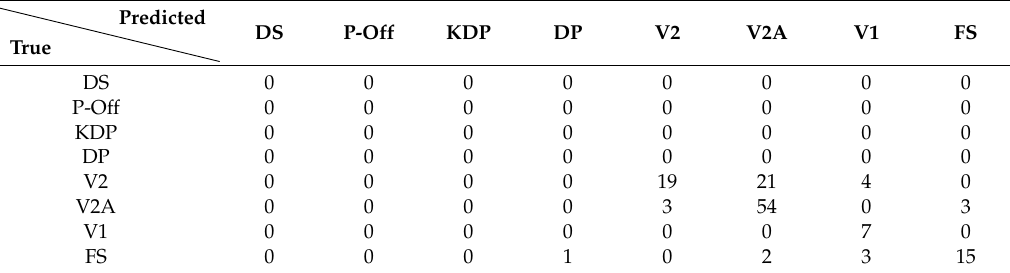
Table A7. Confusion matrix for the flat course, skating style validation set of skier 1 when using the sports biomechanics configuration of